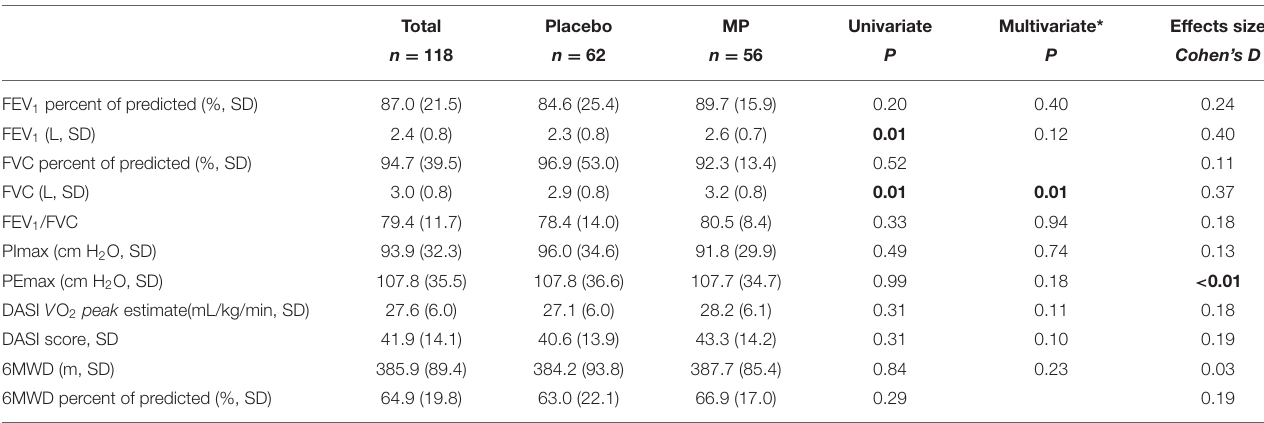
TABLE 2 | Functional and respiratory measurements outcomes on D120 follow-up